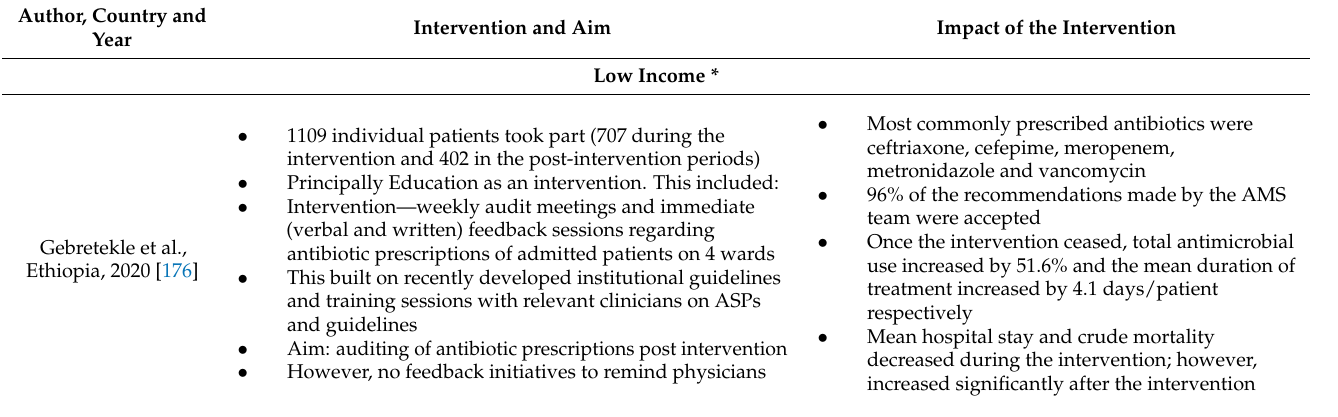
Table 3. Summary of published studies across Africa documenting ASPs and their